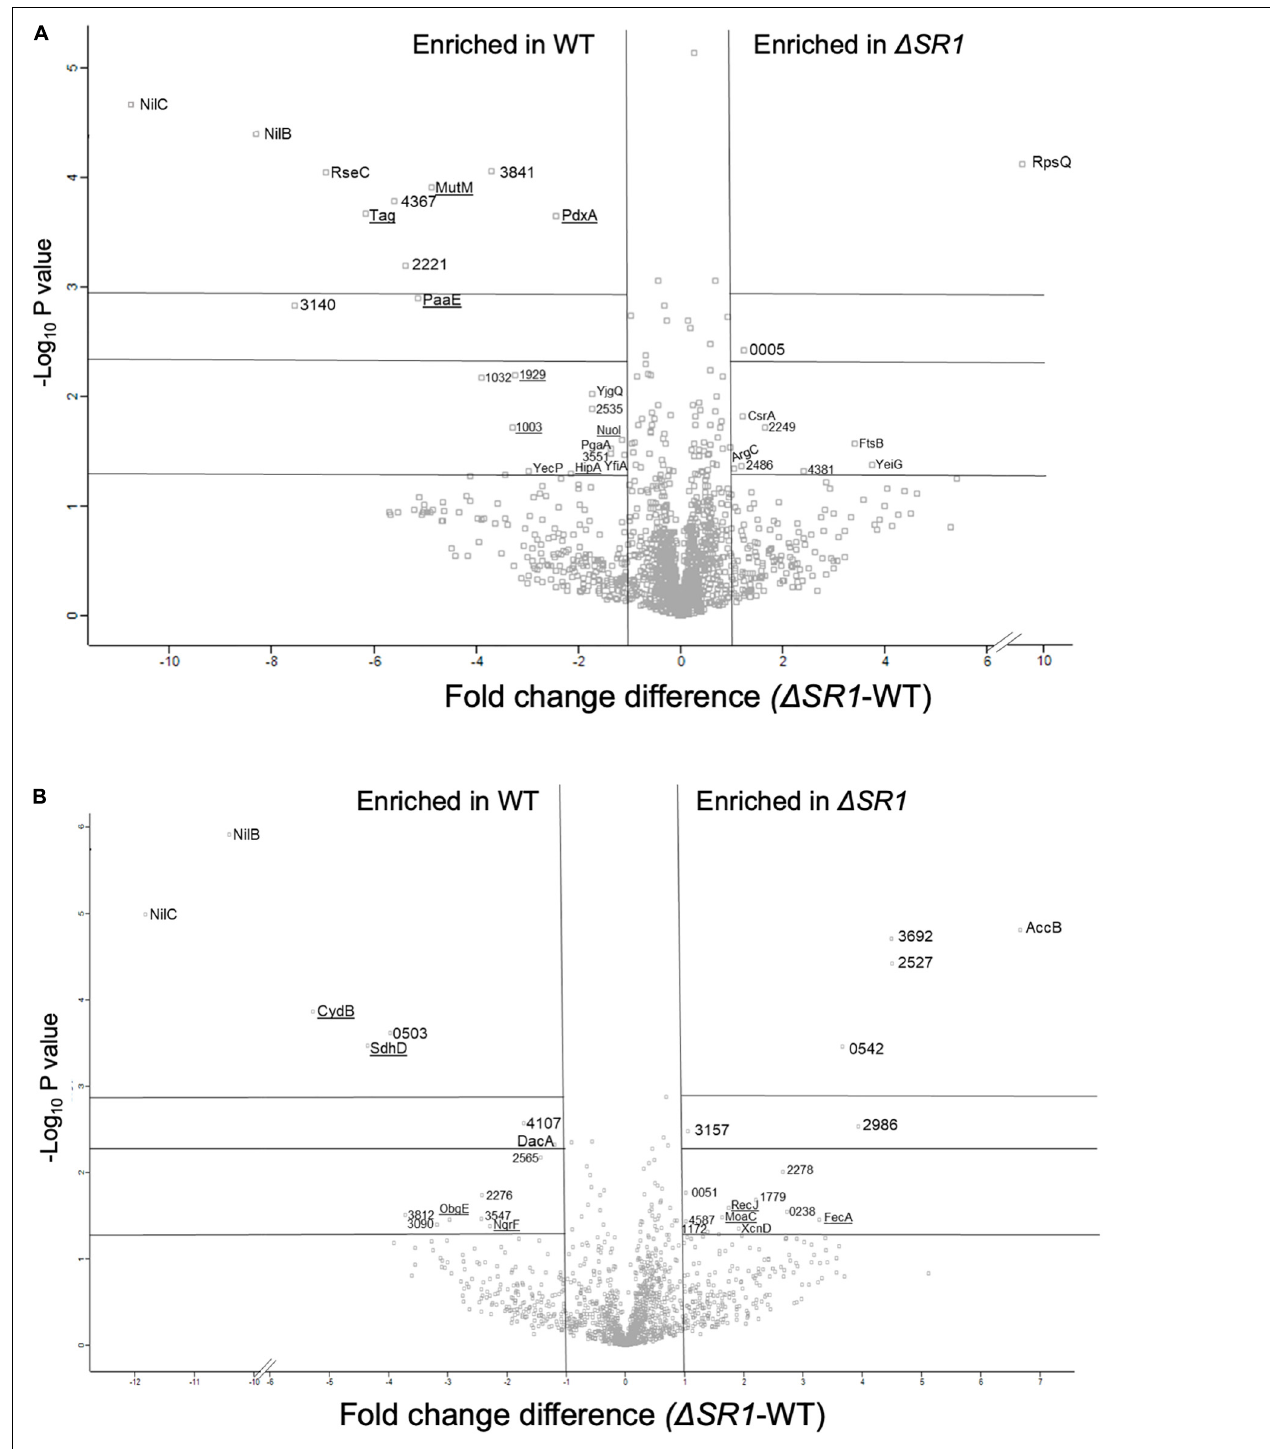
FIGURE 6 | Differentially translated proteins between (cid:49) SR1 and WT show significant differences in metal-related activities (binding, homeostasis, and metabolic pathways). Volcano plot representations of proteins that are differentially present in X. nematophila wild type and (cid:49) SR1 strains for (A) whole cell fraction and (B) supernatant fraction. Proteins indicated on the left of the vertical lines were detected at significantly higher levels (| FC| > 1) in wild type, while those listed to the right were detected at significantly higher levels (| FC| > 1) in the (cid:49) SR1 mutant. Underlined proteins represent proteins with expected metal-binding activity. Significance values (from bottom to top) are indicated by the horizontal lines at p < 0.05, 0.005, and